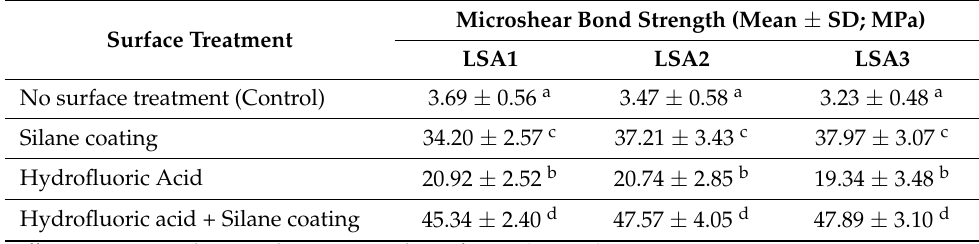
Table 2. Mean and standard deviation of micro-shear bond strengths. Surface